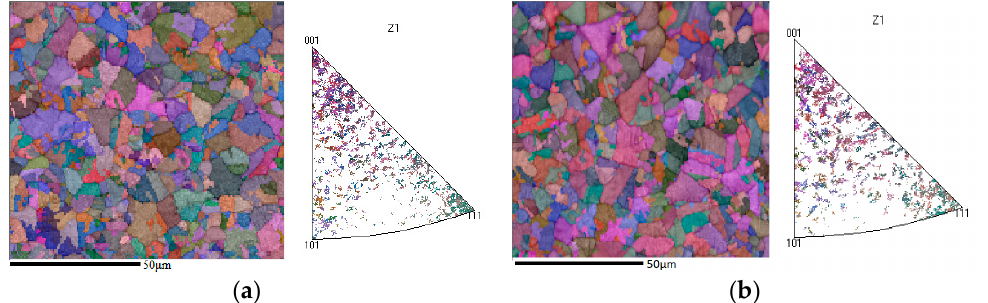
Figure 3. ( a ) EBSD of intrinsic precursor; ( b ) EBSD of 2 × 10 18 /cm 3 phosphorus doped precursor.